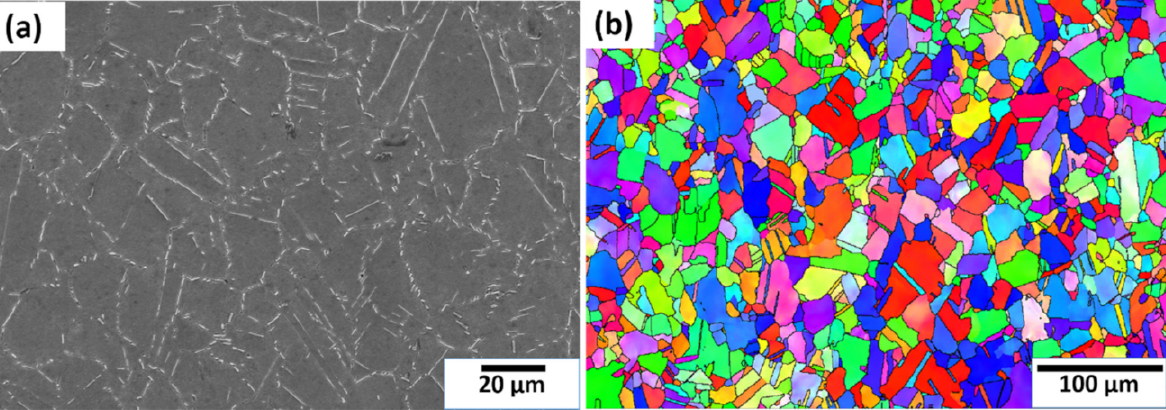
Figure 12. ( a ) SEM micrograph of C&W IN718 showing precipitates and ( b ) EBSD orientation map showing random orientation.